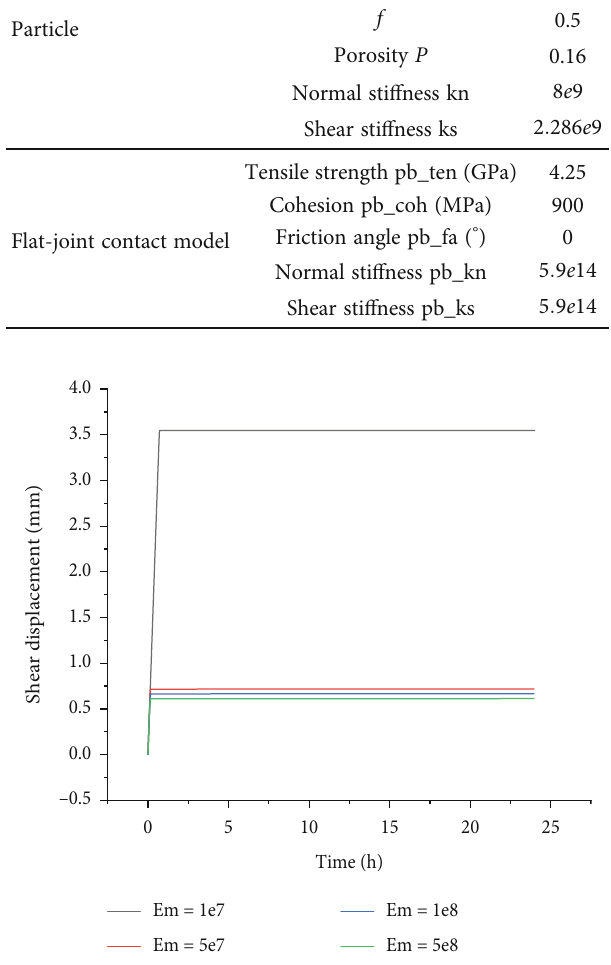
Figure 2: Shear displacement-time relation of unbolted joints under di ff erent E m .